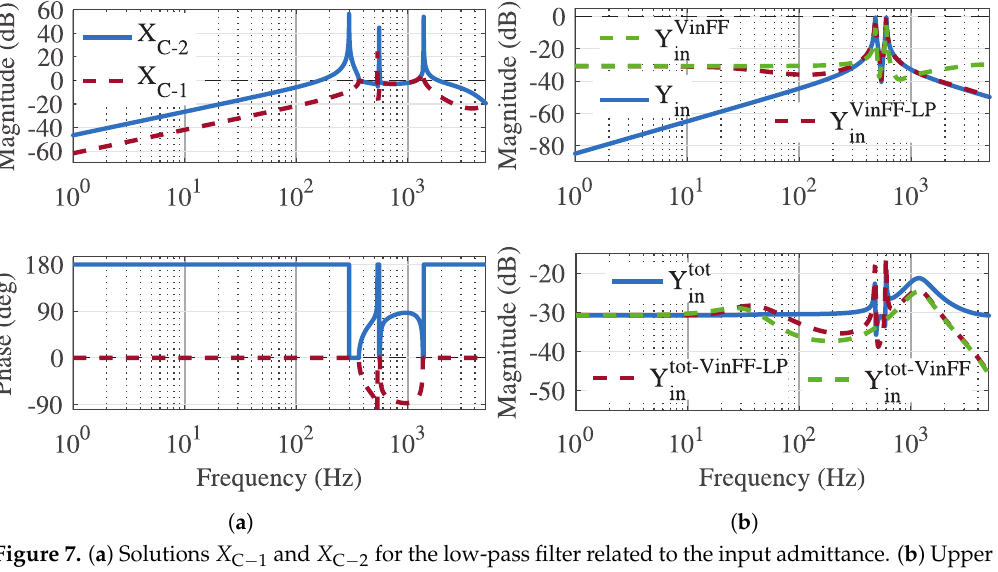
Figure 7. ( a ) Solutions X C − 1 and X C − 2 for the low-pass filter related to the input admittance. ( b ) Upper figure: comparison of the open-loop input admittance gain and lower figure: comparison of the closed-loop input admittance